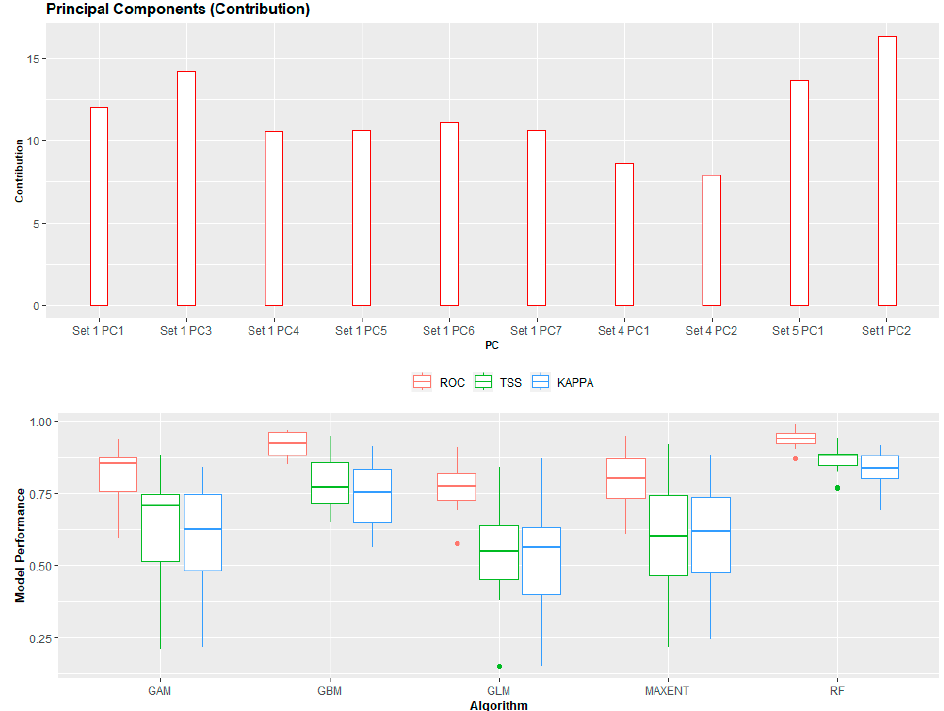
Table 2. The total population living in environmentally suitable areas in SSA (2020). WHO GBD: WHO Global Burden of Disease Regions.